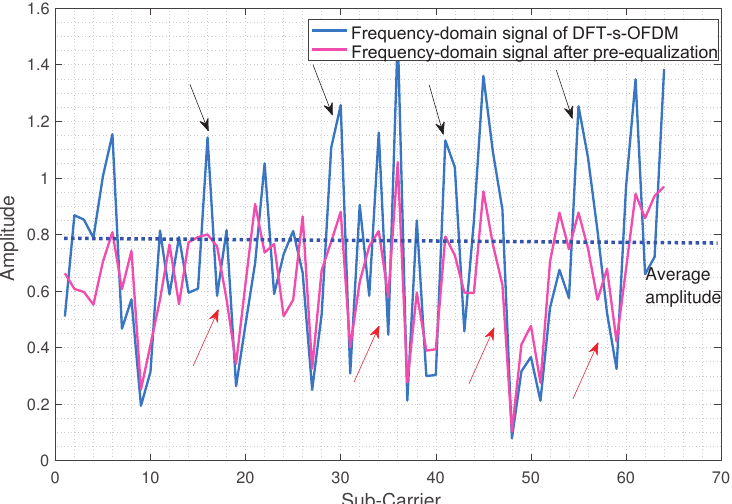
Figure 8. Subcarrier amplitude of DFT-s-OFDM after equalization.